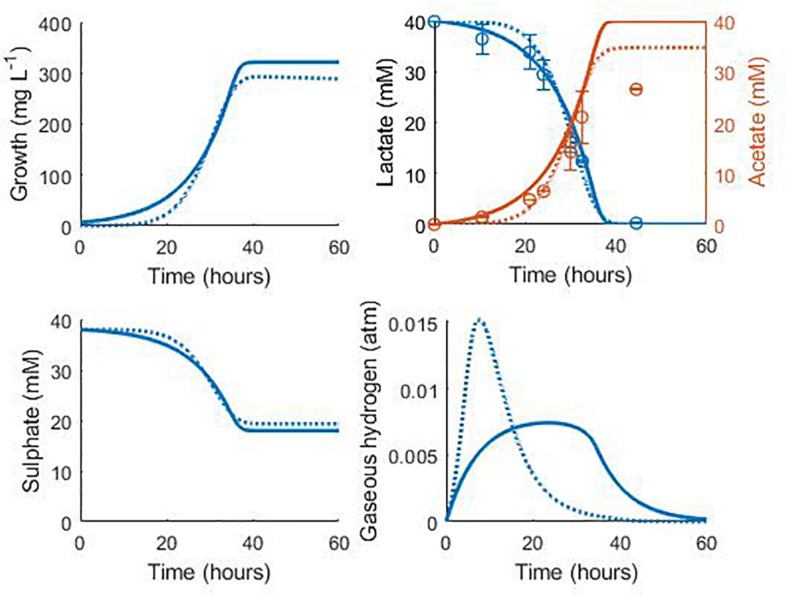
Model prediction for the consumption of lactate and production of acetate in the experimental work of da Silva et al. (2013): continuous lines display the fit of the current model; dotted lines display the fit of the model described in Noguera et al. (1998). See text for full explanation. Continuous line fit: Lactate: R2 = 0.98, ρ = 0.99 (0.95, 0.99), CCC = 0.98, mean bias = 1.2 mM; Acetate: R2 = 0.82, ρ = 0.99 (0.93, 0.99), CCC = 0.88, mean bias = 4.12 mM. Dotted line fit: Lactate: R2 = 0.98, ρ = 0.99 (0.96, 0.99), CCC = 0.98, mean bias = 1.32 mM; Acetate: R2 = 0.90, ρ = 0.99 (0.97, 0.99), CCC = 0.93, mean bias = 2.08 mM.